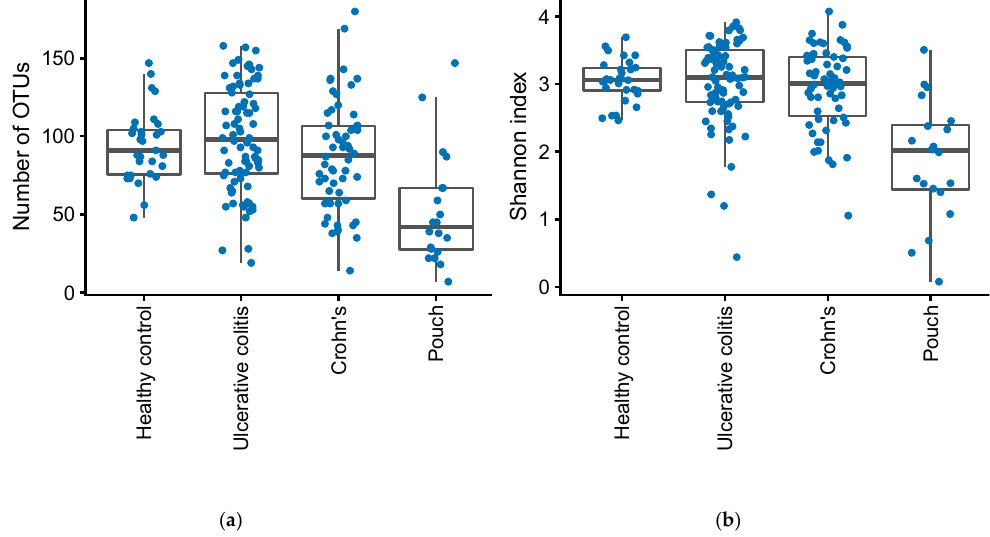
Figure 3. Number of OTUs ( a ) and Shannon diversity index ( b ) in patients with Inflammatory Bowel Disease (Crohn’s disease, N = 58 and Ulcerative Colitis, N = 82), controls, N = 31, and in patients with an ileo-anal pouch anastomosis, N = 20.